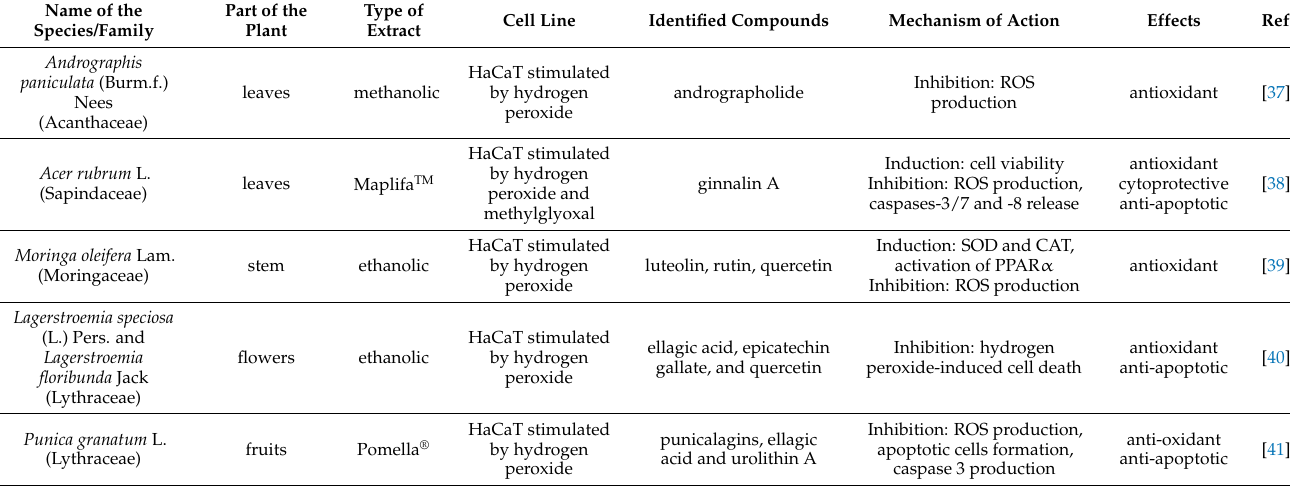
Table 1. Selected plant extracts from different species with identified compounds and their in vitro effect on H 2 O 2 -stimulated human